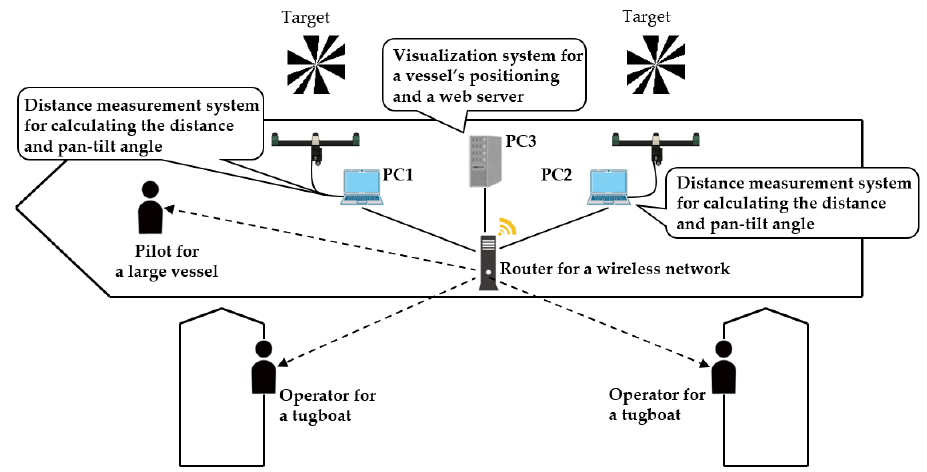
Figure 11. Overall configuration of the portable interface system sharing the positioning information to support a berthing